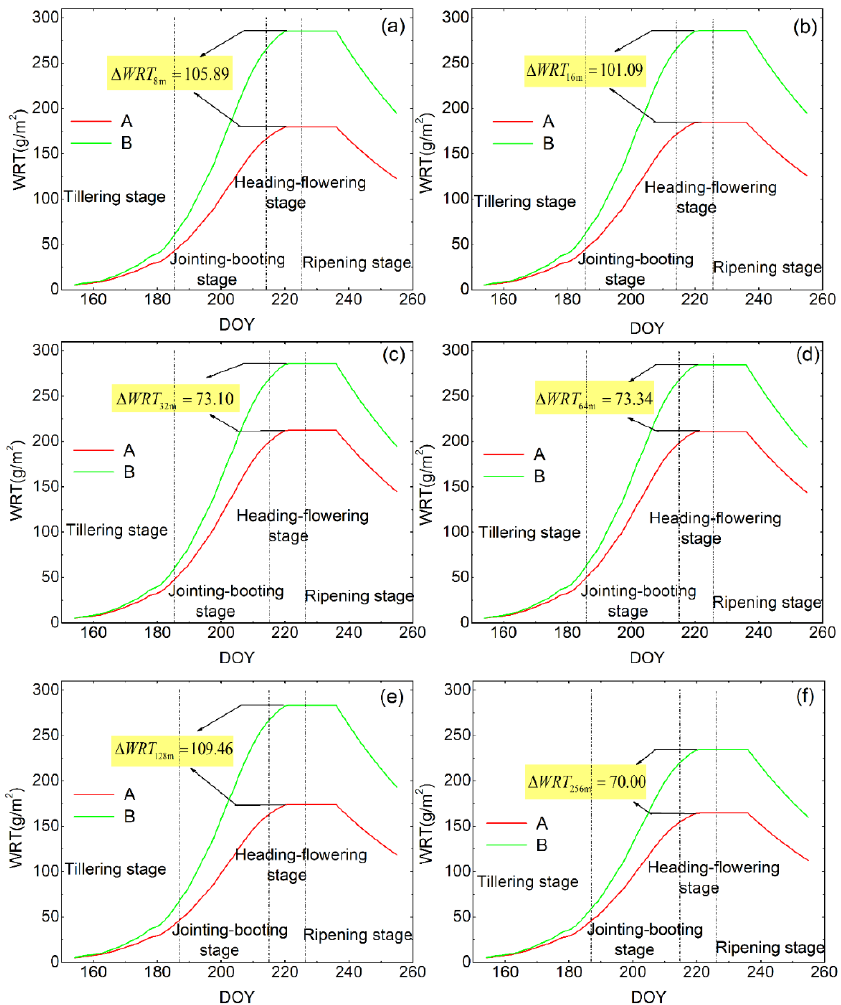
Figure 5. The effects of different spatial resolution (8 m, 16 m, 32 m, 64 m, 128 m, and 256 m) on WRT (dry weight of roots) estimation based on the RS-WOFOST framework of the two study areas.